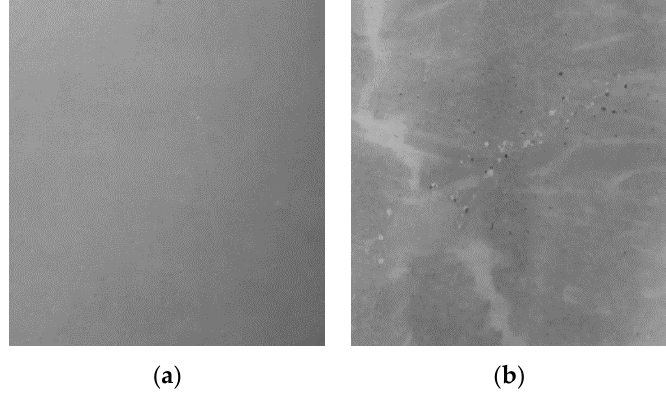
Figure 14. ( a ) Surface of test specimen L1-20 A before the laboratory irrigation; ( b ) surface of test specimen L 1-20 A after 4 weeks of laboratory irrigation.